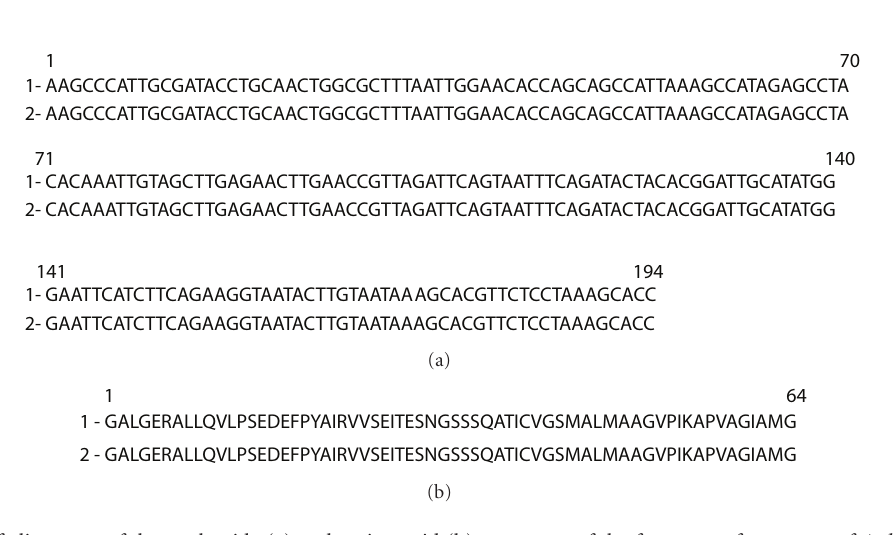
Figure 2: Results of alignment of the nucleotide (a) and amino acid (b) sequences of the fragment of pnp -gene of A. laidlawii PG8 (1) as well as amplicon (2) obtained as a result of PCR with primers for detection of the nucleotide sequence of pnp -gene of A. laidlawii PG8 when DNA of plants grown in medium with the mycoplasma cells was used as a matrix. Sequences of forward and reverse primers are indicated with